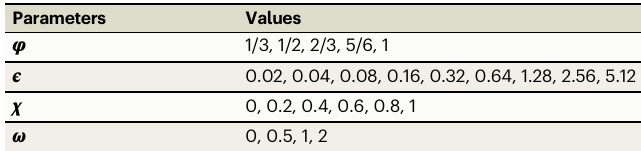
Table 1 | Dimensionless parameter values explored in this work